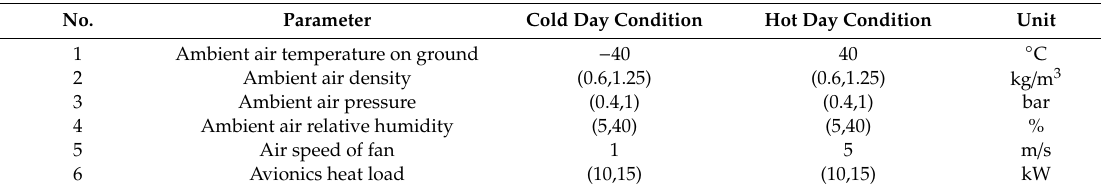
Table 8. Parameters of simulation cases.